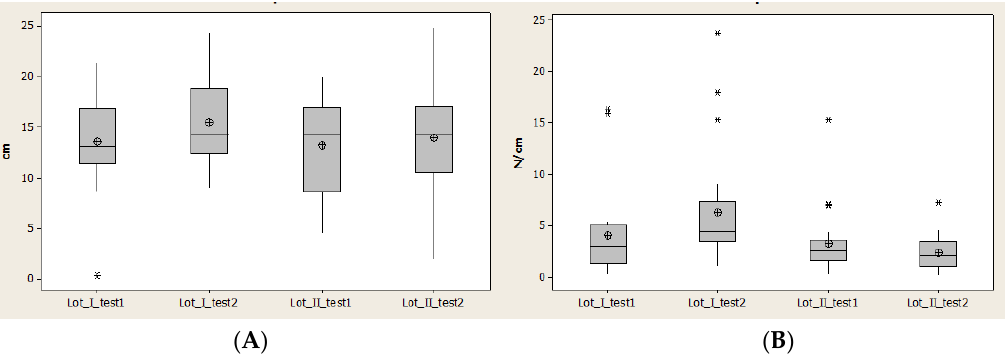
Figure 12. Plantar region midfoot: ( A ) contact area, ( B ) Pmax distribution. * Small distribution, ** High distribution. Maximal pressure (Pmax) had many values outside of normal interval. In lot I in the